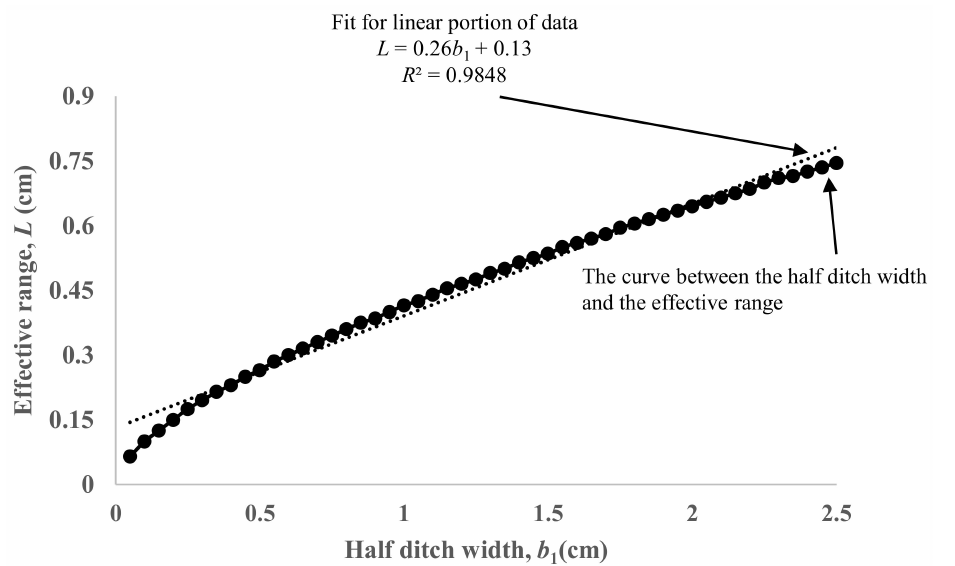
Figure 5. Plot of the half ditch width versus the valid range of models with a linear interpolation line and equation for the linear portion of the plot.